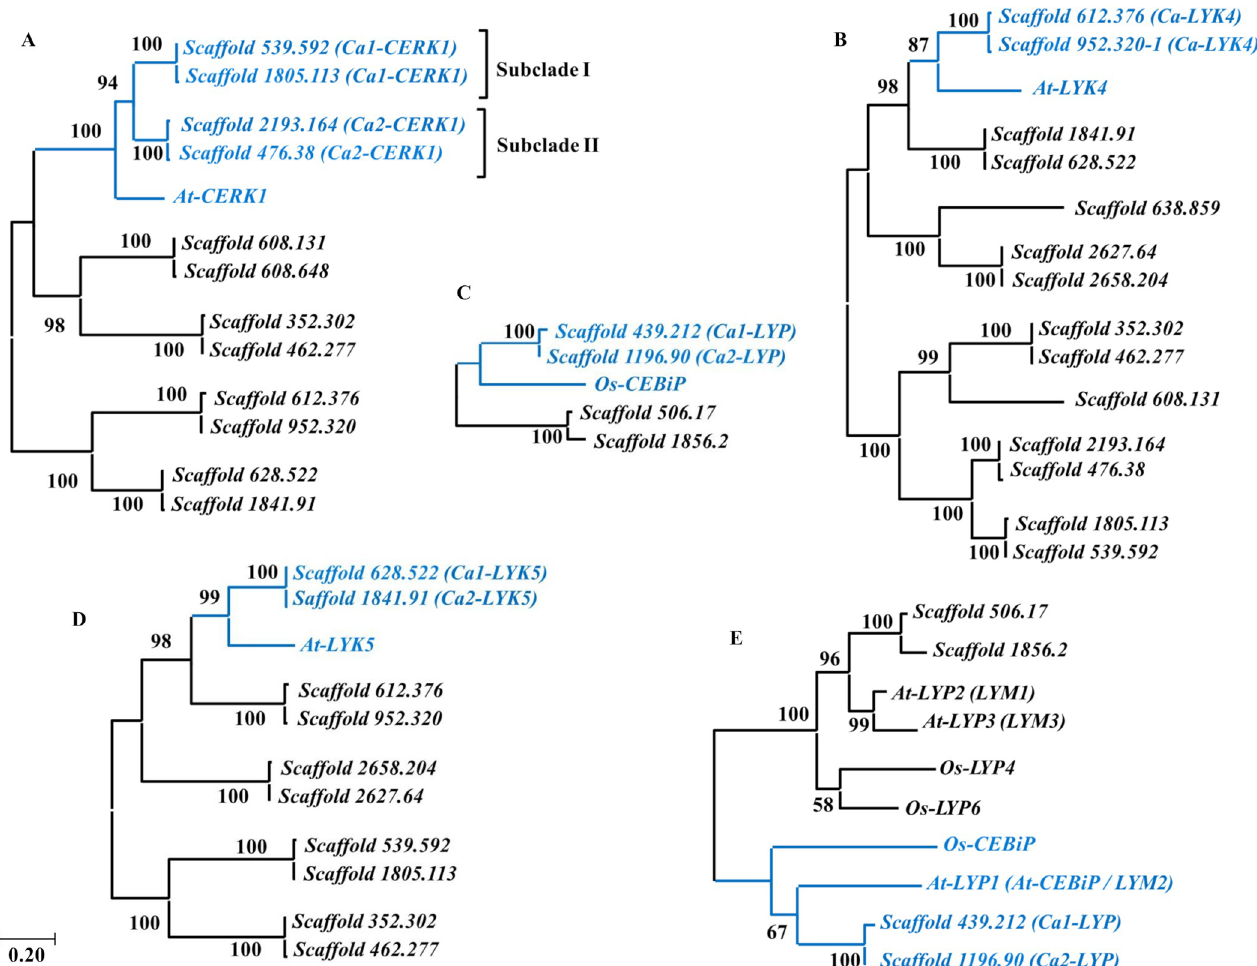
Fig 1. Phylogenetic analysis of the selected sequences for C . arabica by comparison with the reference PRRs. (A) CERK1 , (B) LYK4 , (C) CEBiP , (D) LYK5 , (E) CEBiP and reference proteins belonging to the LYP ( CEBiP- like) group. The phylogenetic trees were constructed with complete amino acid sequence alignments using the Maximum Likelihood method with a bootstrap of 1000 replications. The cluster clade of candidate sequences for C . arabica and reference sequences are highlighted in blue.